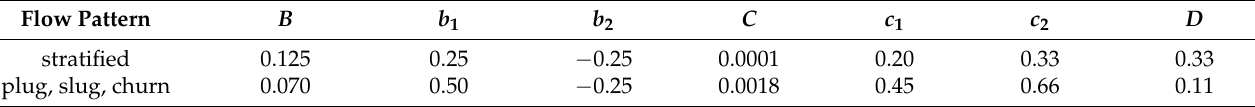
Table 3. Constants and exponents in Equations (18) and (19).